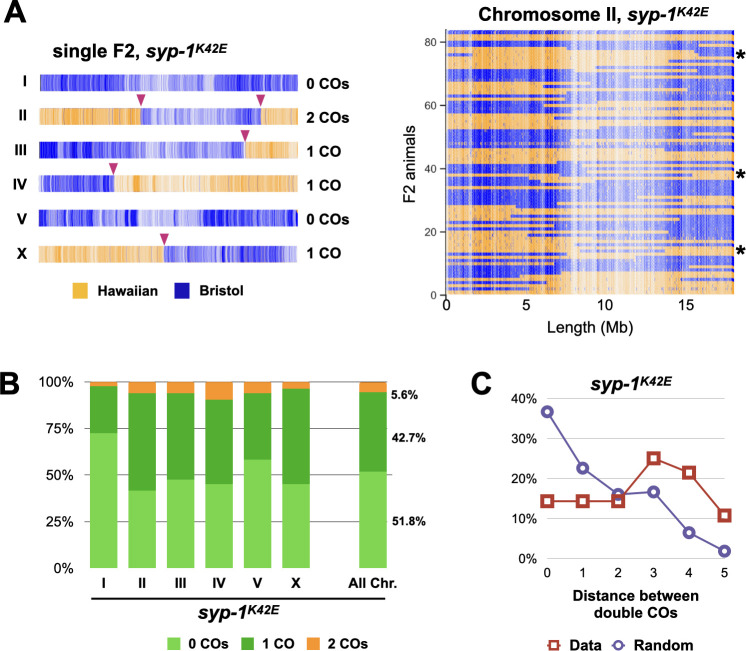
The N-terminus of SYP-1 regulates the number and distribution of crossovers.A) SNP profile of traceable meioses in syp-1K42E (20°C) animals allowing localization of crossovers (COs). Each vertical line depicts a unique SNP (Hawaiian, yellow; Bristol, blue), while each horizontal bar represents a single chromosome. Left, SNP profile of a single cross-progeny showing chromosomes with single, double, and no crossovers (maroon arrows). Right, map of the SNPs along chromosome II in all 84 sequenced cross-progeny. Note the unique position of every crossover, and the presence of double crossovers in some progeny (several examples noted with asterisks). See S5 Fig for all mapped crossovers. B) Prevalence of crossovers for each chromosome and for all combined chromosomes in syp-1K42E animals reveals the presence of double crossovers. C) Interference between crossovers is reduced but intact. In syp-1K42E (20°C) chromosome that harbor two crossovers, crossovers are more distant from each other (maroon) than would be expected by chance (‘Random’, purple). The chromosomes were divided into 6 equal-sized intervals. N = 28 double crossovers from 84 F2 animals.